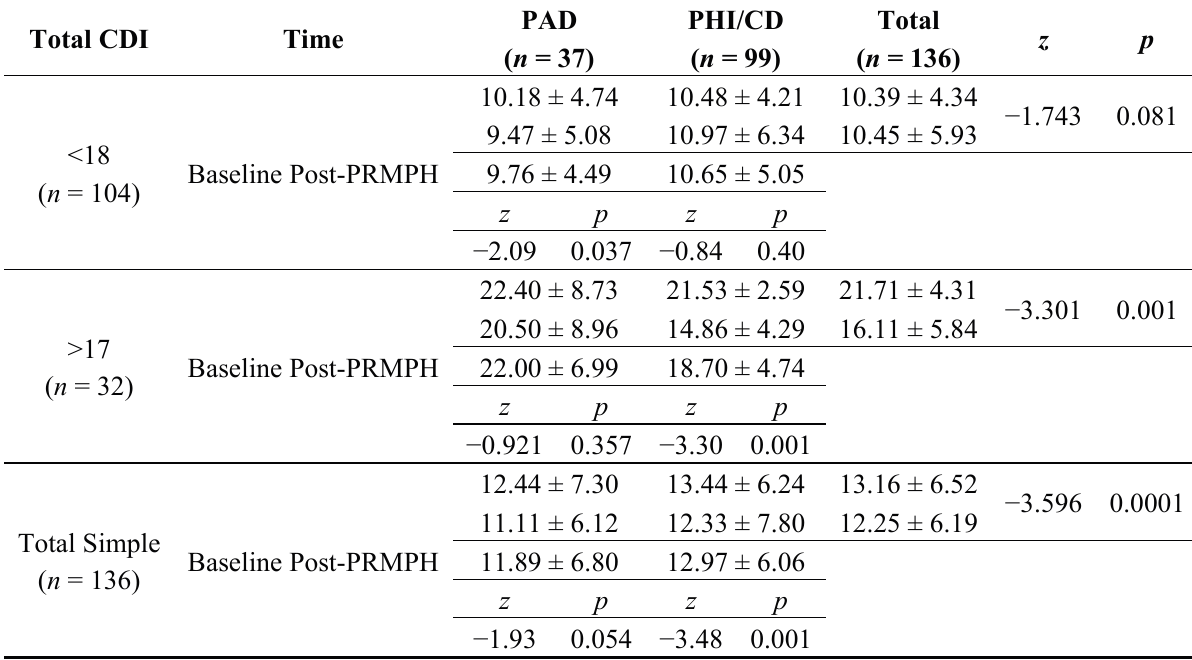
Table 1. Children’s Depression Inventory (CDI) values, by ADHD subtypes and subgroups, before and after prolonged release of methylphenidate